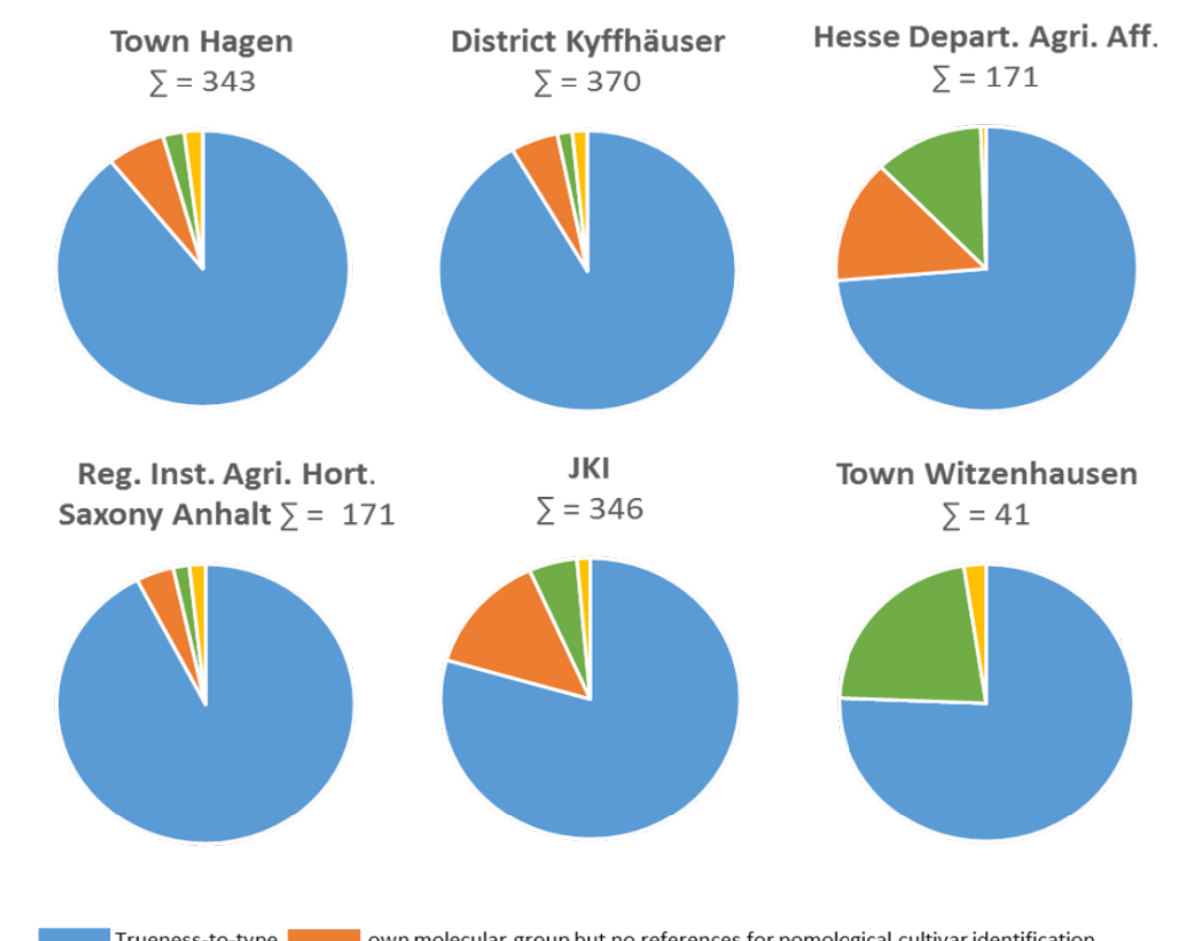
Figure 1. Determination of trueness-to-type based on pomological and molecular analysis data of the sweet cherry accessions of the German National Fruit Genebank (Deutsche Genbank Obst, DGO), depending on the collection of the six partners involved .